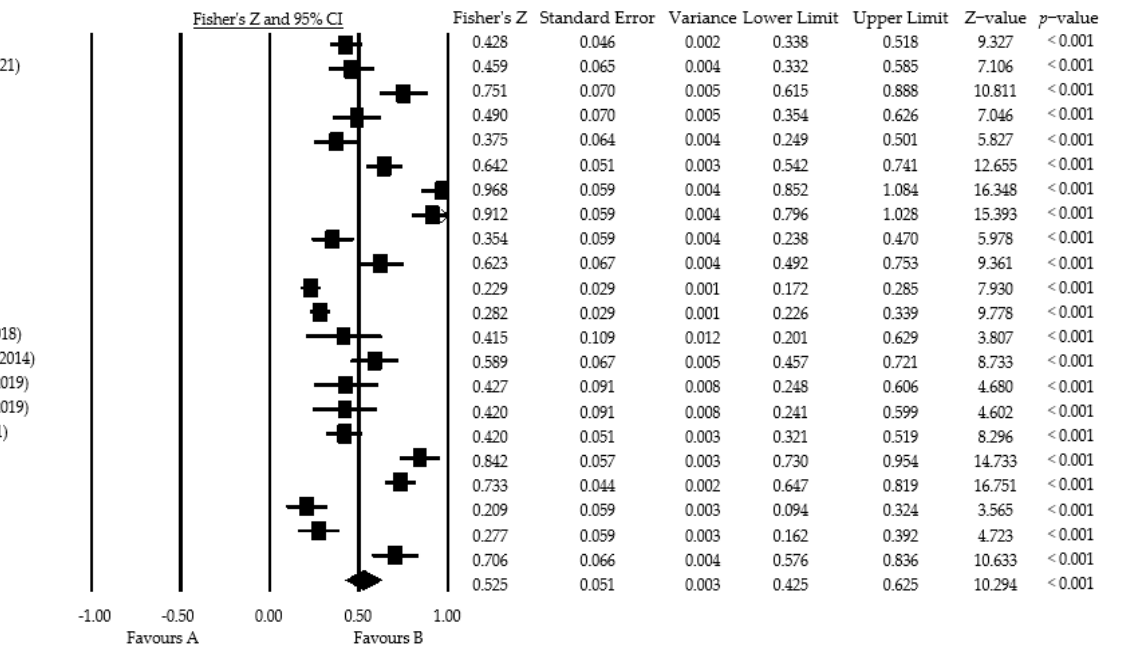
Figure 5. Total sample forest plot [30,45,46,57,60,74 –